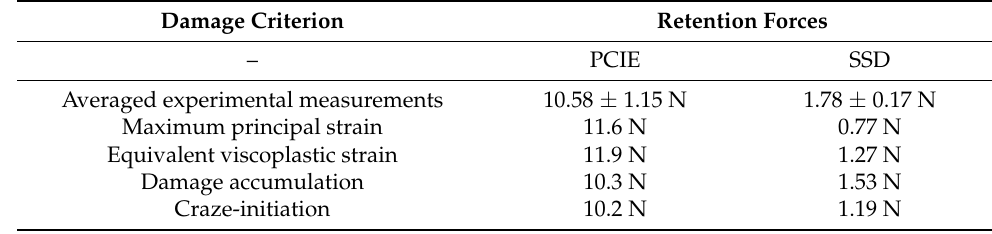
Figure 14. Force-displacement relationships of ( a ) PCIE connector and ( b ) SSD connector based on the experiments and simulations during the insertion/withdraw strokes. Table 3. Comparisons of the retention forces of PCIE and SSD connectors based on the experiments and simulations with various damage